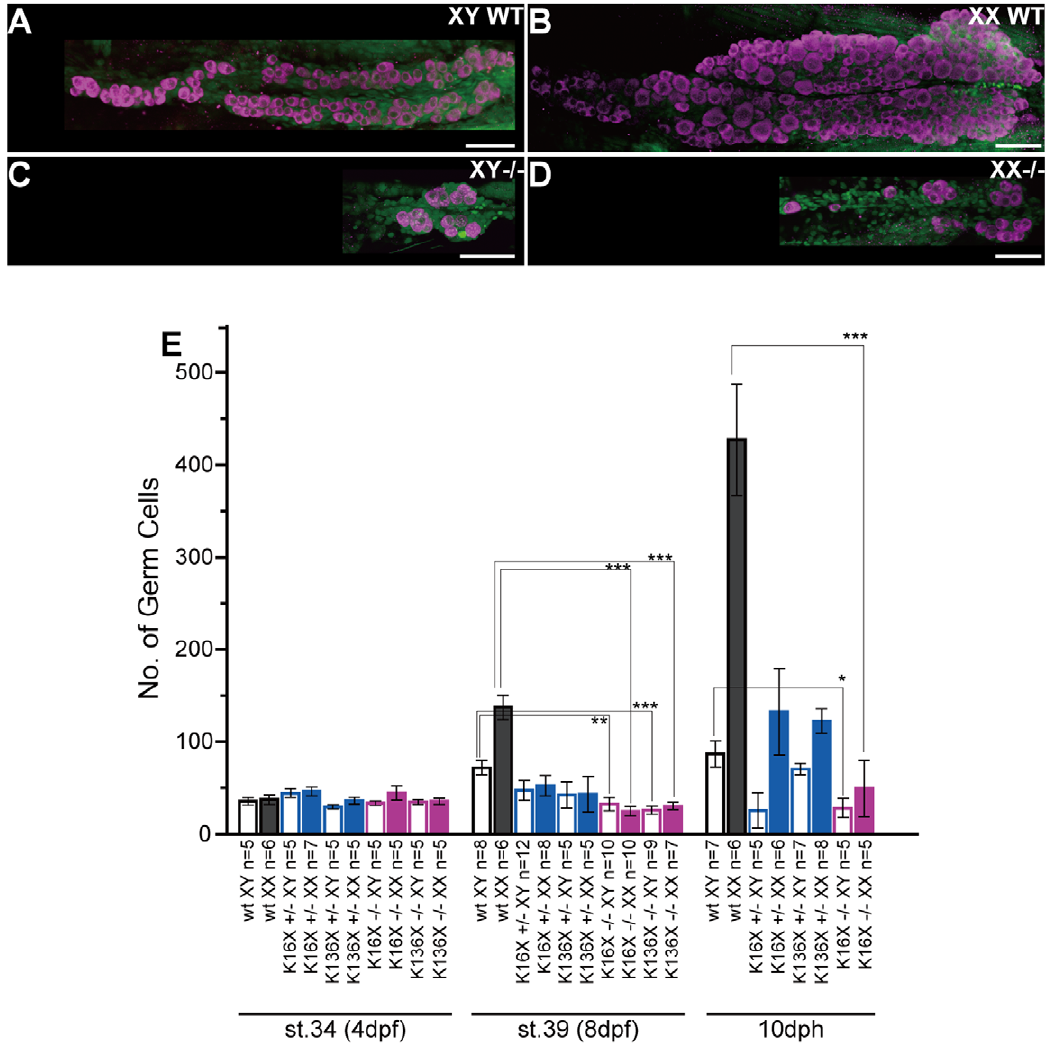
Figure 3. Gonadal morphology and germ cell number in the sox9b mutant medaka. (A–D) Ventral images of the medaka gonad at 10 dph obtained by confocal microscopy. Germ cells and nuclei were stained with an anti-OLVAS antibody (purple) and DAPI (green), respectively. The tissue structures are formed but the germ cell numbers are reduced in the mutant gonads. (E) Number of germ cells in wild-type and sox9b heterozygous and homozygous mutant medaka during gonad differentiation. * P , 0.05, ** P , 0.01, *** P , 0.001, Student’s t test. All values are the mean 6 SEM. Scale bars, 50 m m.